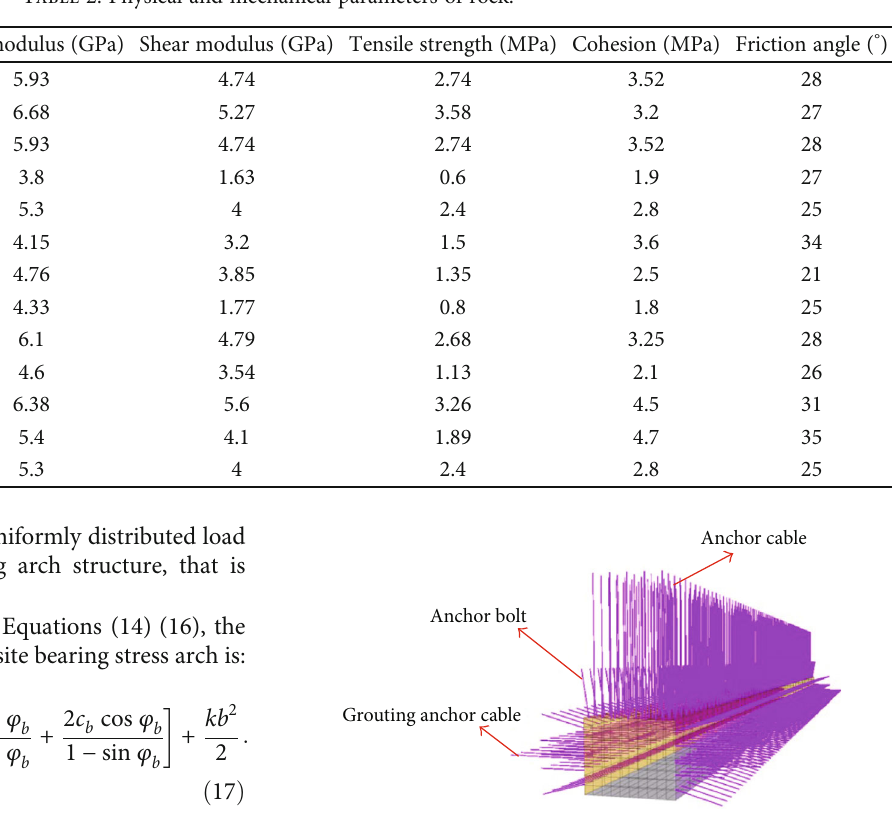
Figure 10: The support structures in numerical